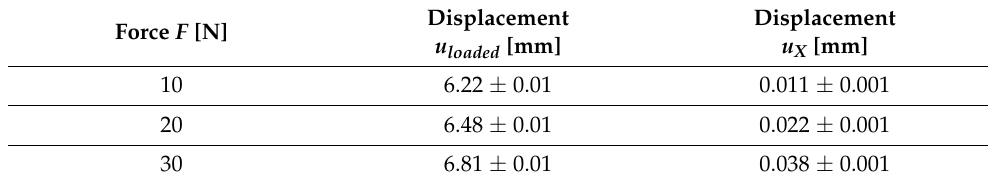
Table 1. Measured displacement u loaded and force F , and calculated displacement u X .